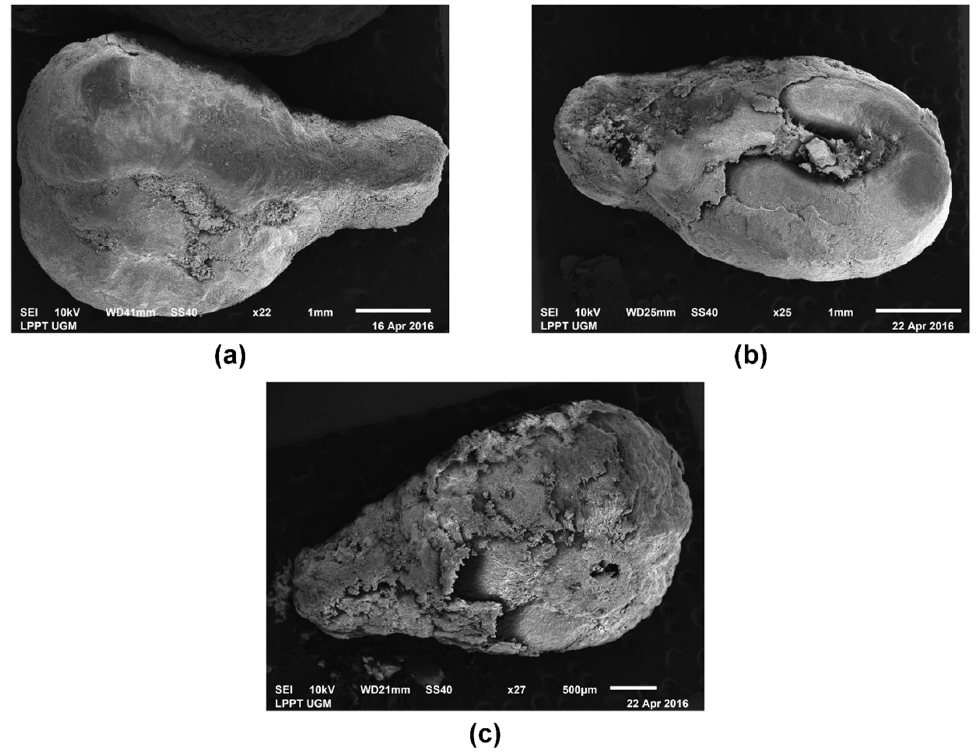
Figure 4. Scanning electron micrographs (SEM) of selected activated carbon samples: ( a ) H180K050; ( b ) H220K050; and, ( c ) H250K050.